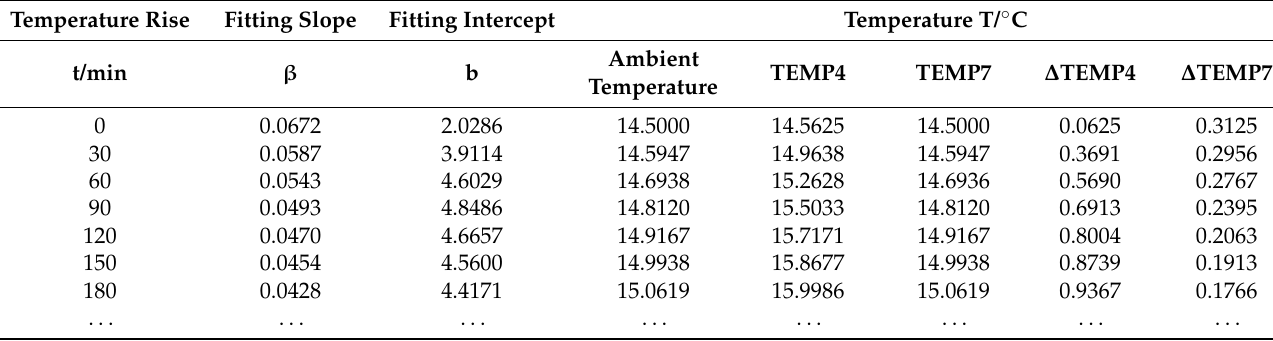
Table 4. Slope and temperature statistics